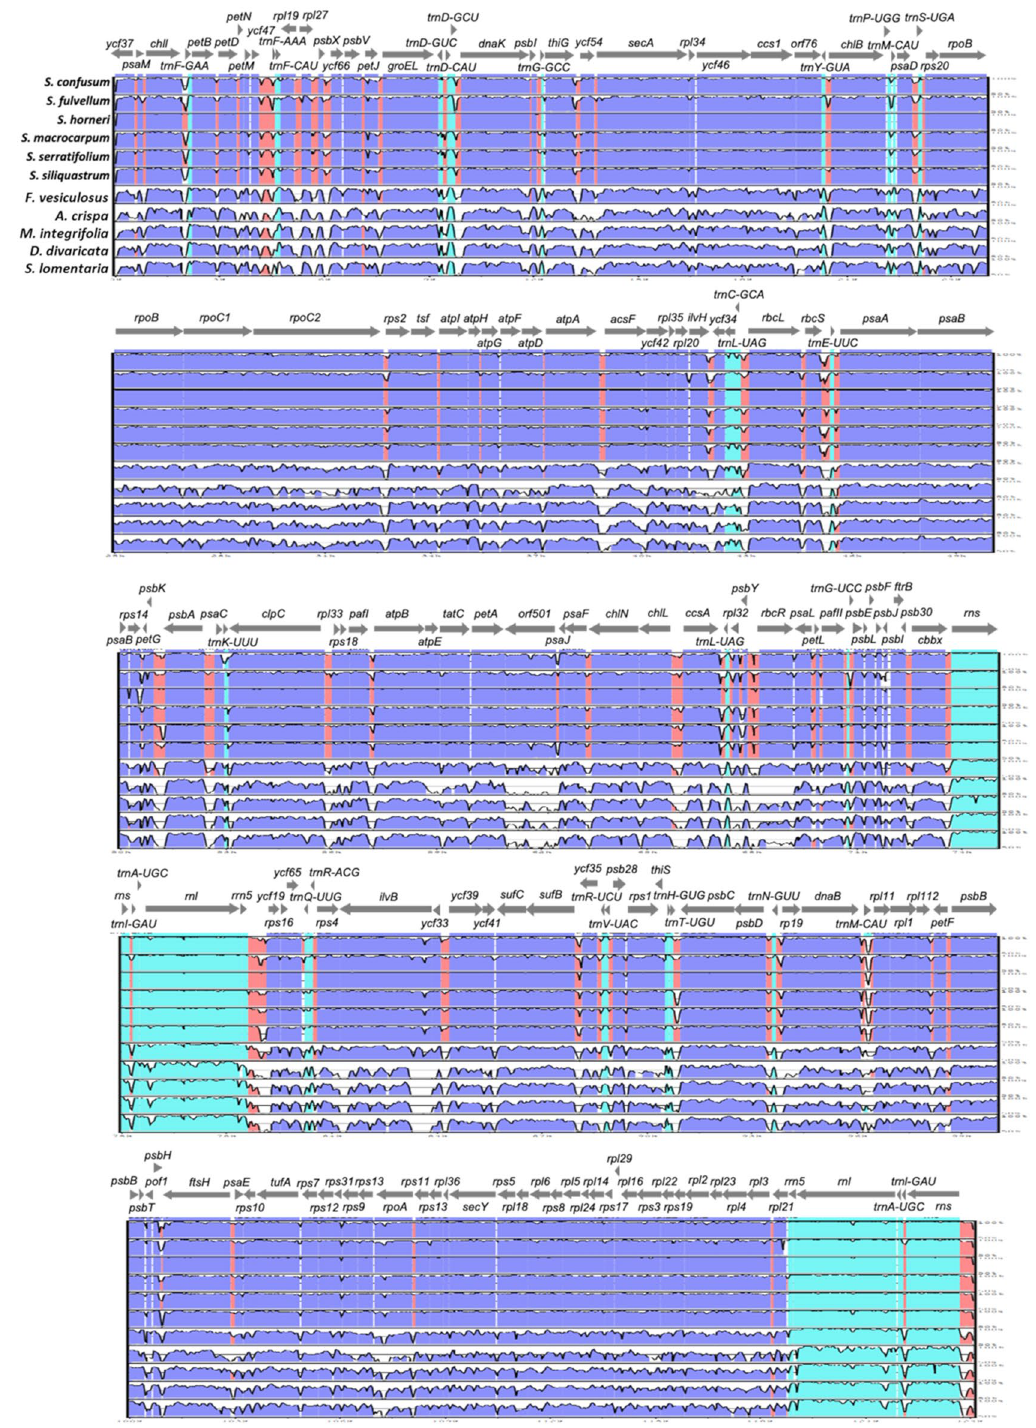
Figure 5. Alignment for sequence similarity among the 12 Phaeophyceae chloroplast genomes. Chloroplast genome of S. horneri (NC_02856) was used as the reference. Untranslated, conserved non-coding and coding regions were colored by skyblue, red, and blue,